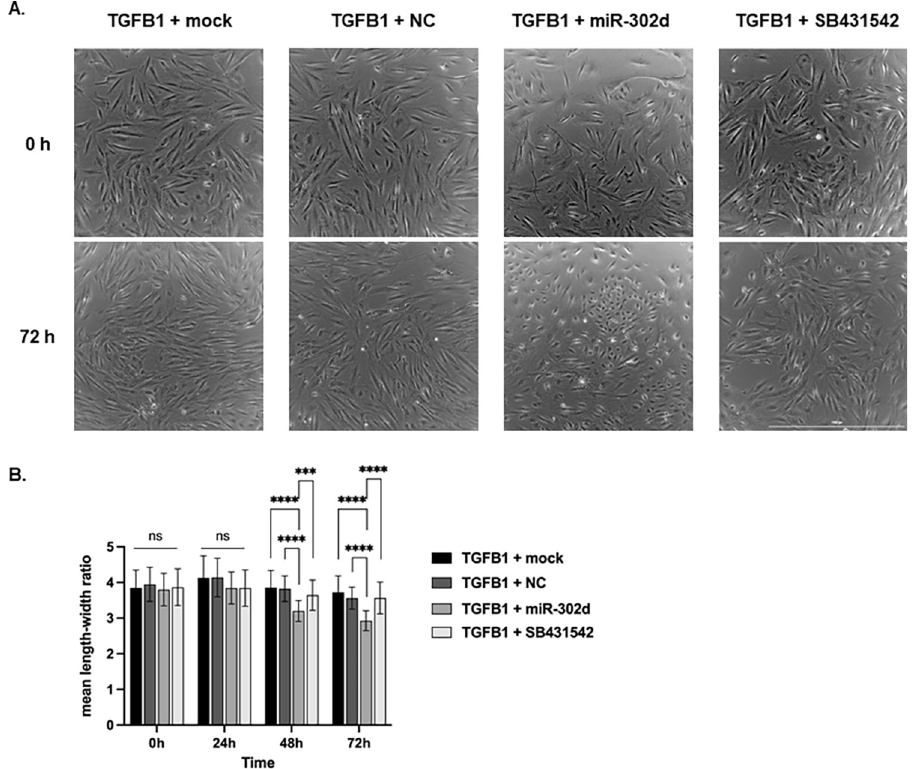
Fig 6. miR-302d reverts TGFB-induced mesenchymal hRPE cells towards an epithelial morphology. Following 4 d incubation of TGFB1, hRPE cells were transfected with mock, NC, miR-302d, or exposed to SB431542. (A) The morphology of hRPE cells at the beginning of transfection and 3 d later (S2 Video). The scale bar represents 1000 μ m. (B) The mean length-width ratio changes of hRPE cells after transfection. Unpaired two-tailed t-tests (n = 3) were performed. The error bars represent SD. ns, non-significant, ��� p < 0.001, ���� p <